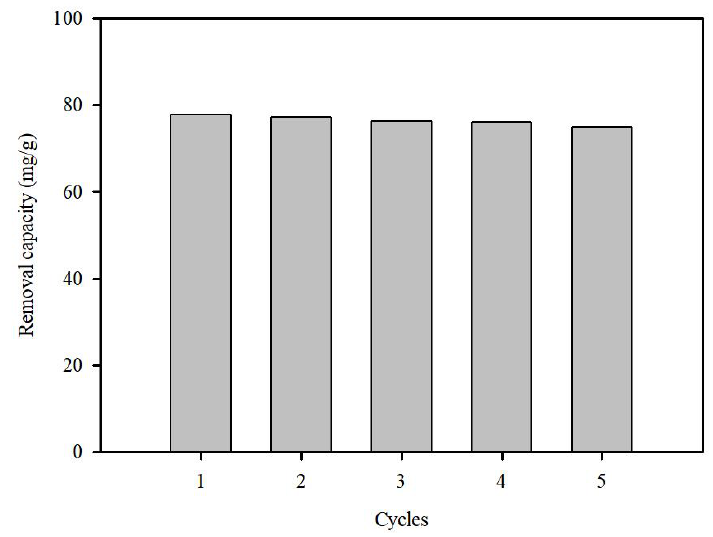
Figure 9. Regeneration studies of S.P@Ca-SA for Pb(II) over five cycles